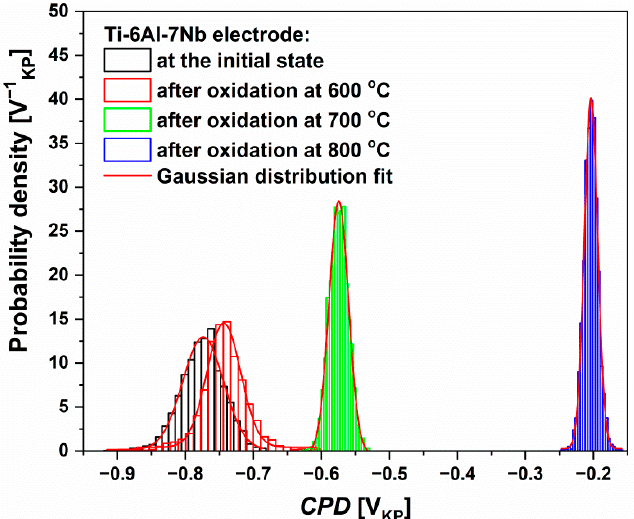
Figure 11. The contact potential difference histograms determined for the Ti-6Al-7Nb alloy surface before and after isothermal oxidation at 600, 700, and 800 °C. Table 6. Statistical parameters for the contact potential difference maps of the Ti ‐ 6Al ‐ 7Nb alloy surface before and after isothermal oxidation at 600, 700, and 800 °C, where CPD av —the average